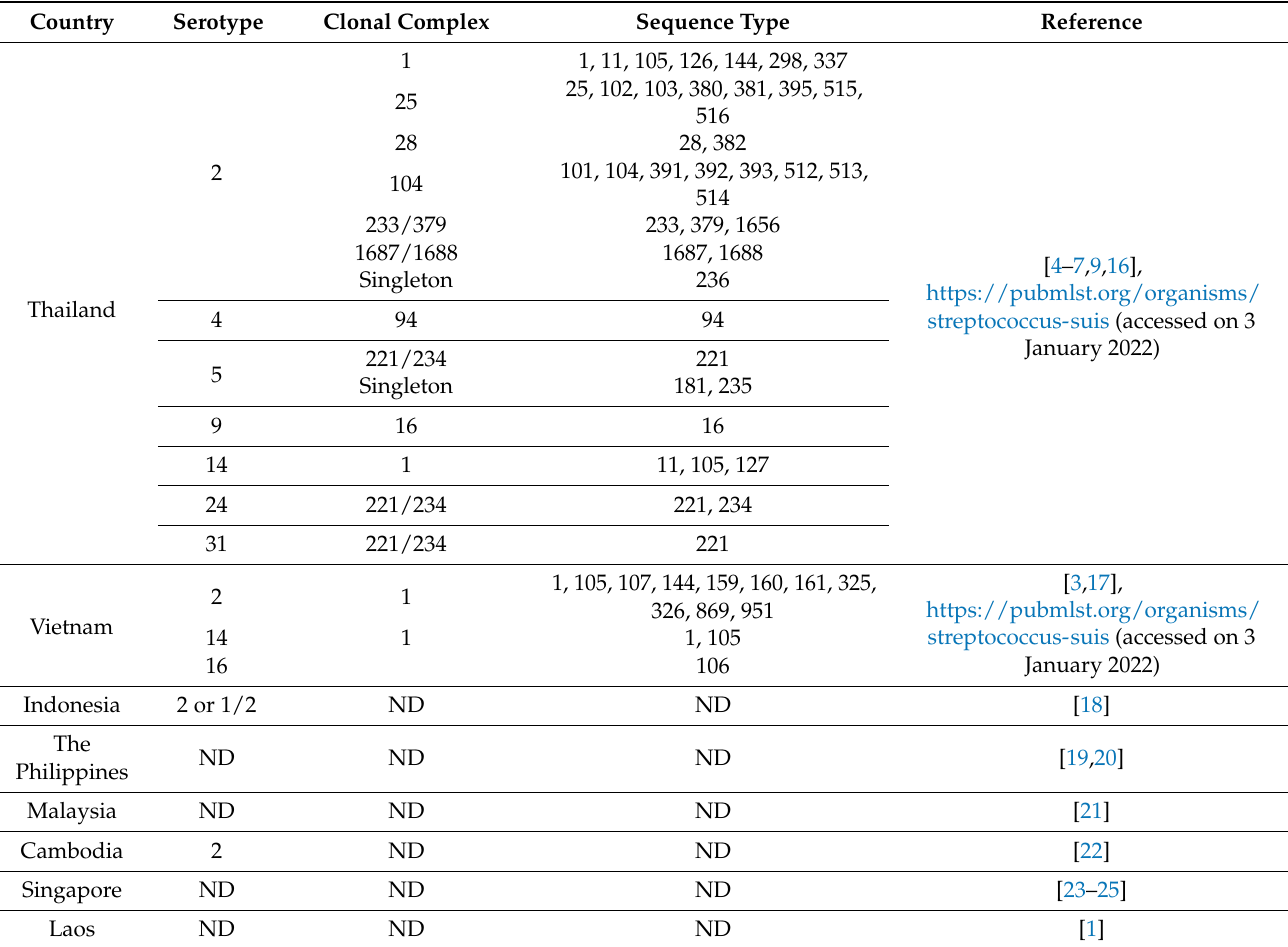
Table 1. Serotypes and sequence types of human S. suis reported in Southeast